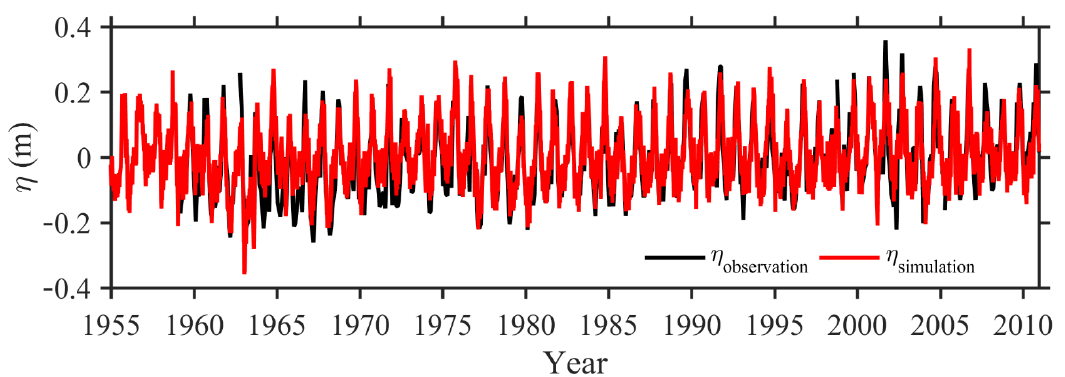
Figure 3. The observed and simulated monthly averaged sea surface height anomaly at the tidal gauge of Lvsi.